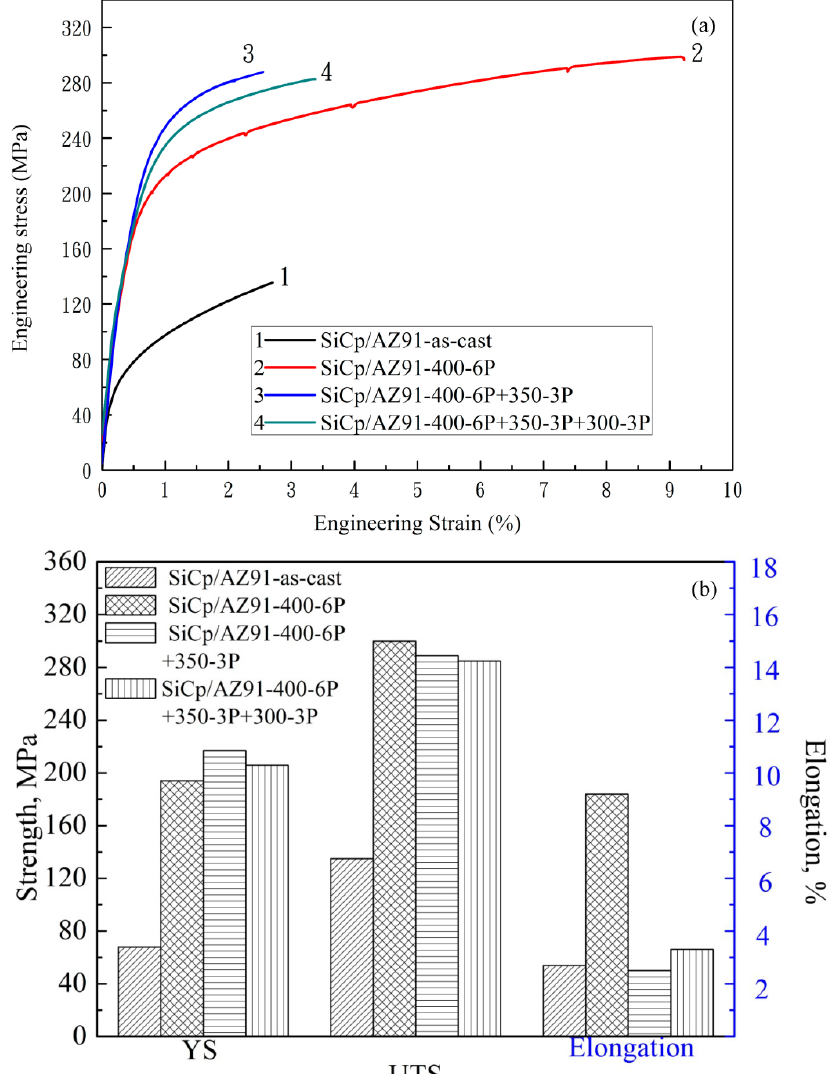
Figure 11. ( a ) The engineering stress–engineering strain curves and ( b ) tensile strength of the nano-SiCp/AZ91 composites after multi-pass forging with varying temperatures.